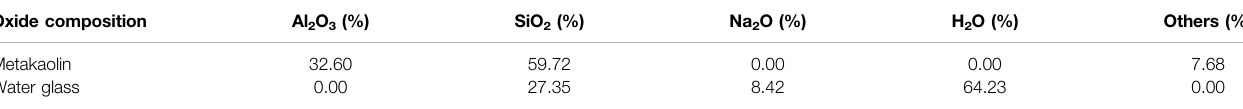
TABLE 1 | Chemical composition of metakaolin and water glass. Oxide